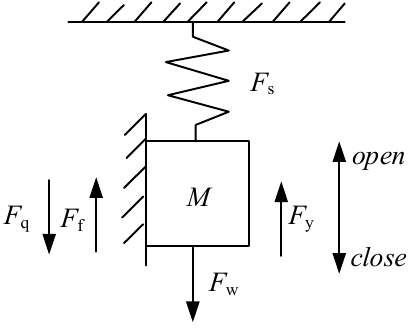
Figure 3. Load force analysis of the PCSM.